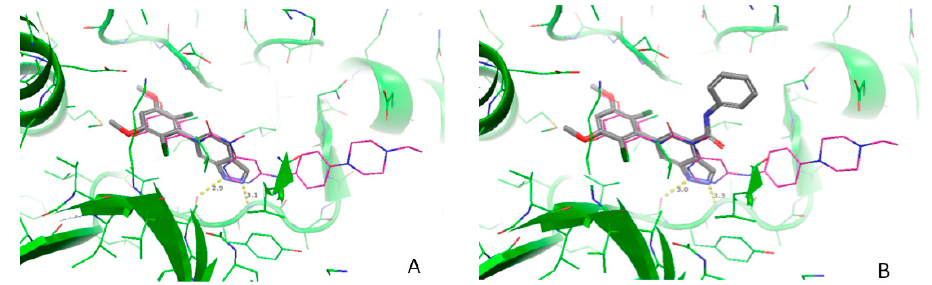
Figure 2. The predicted binding conformation of compound 4 ( A ) and 10a ( B ) in the ATP binding site of FGFR1 based on the docking studies.